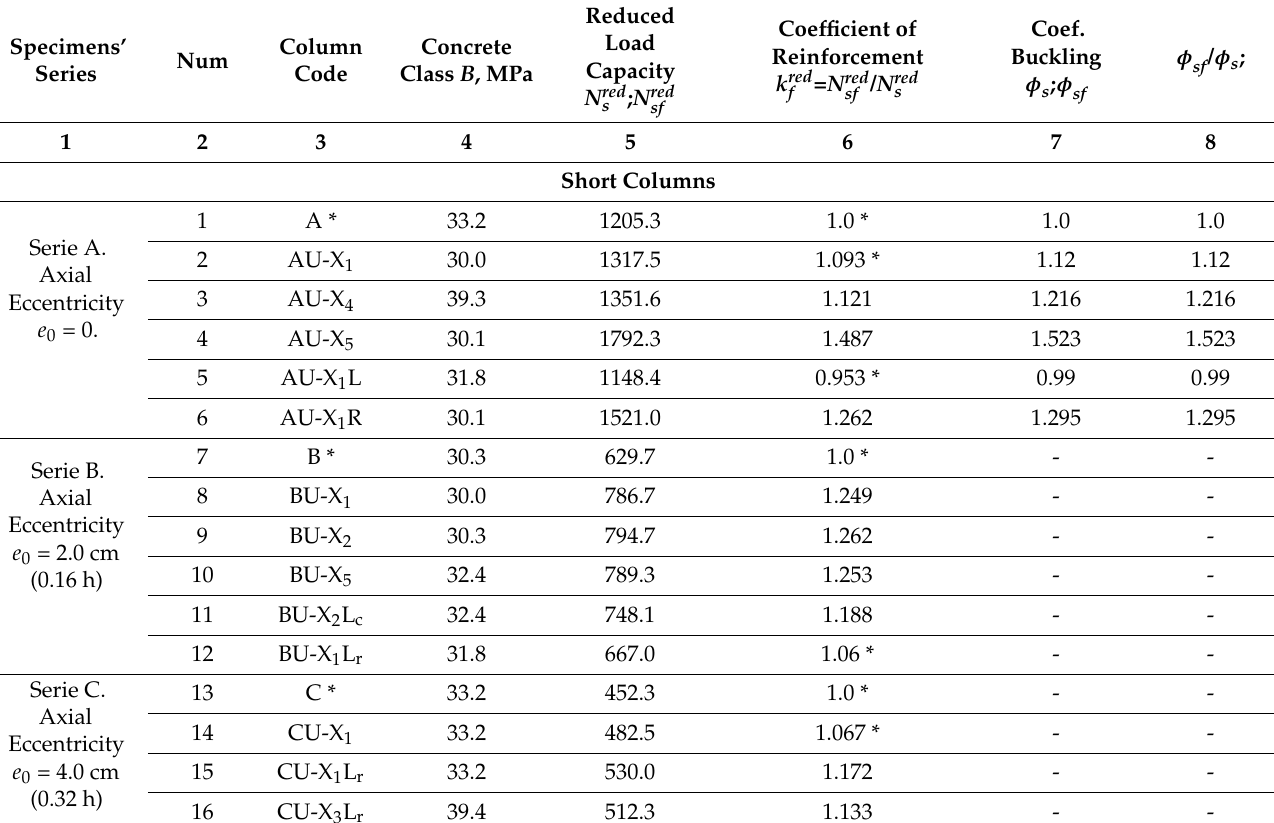
Table 6. Experimental values of the composite gain ( k red the columns N red s . f